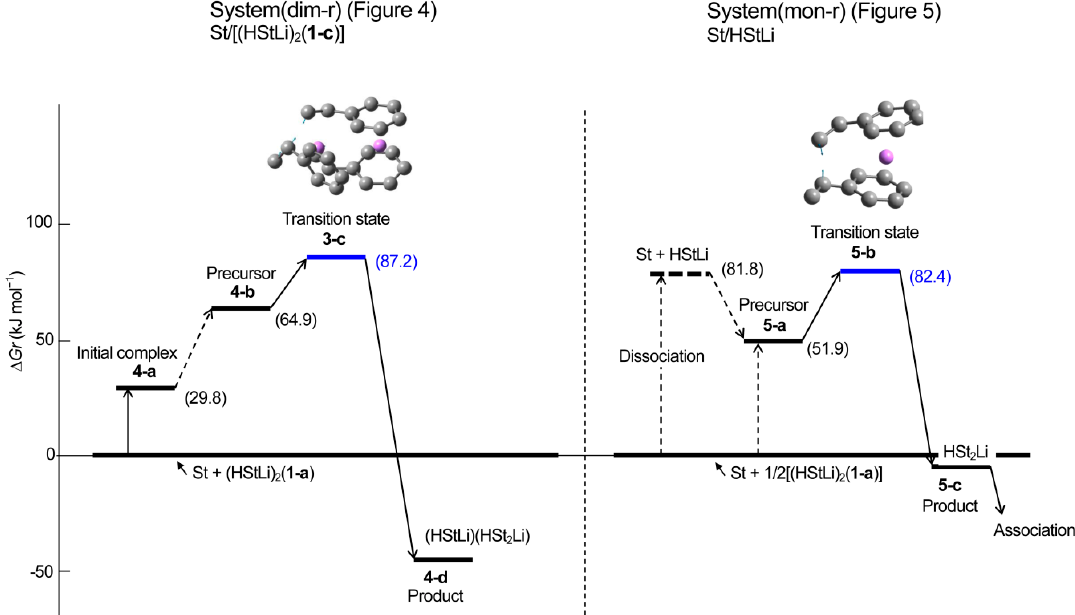
r)) and HStLi (system(mon-r)). and HStLi (system(mon-r)). Polymers 2019 , 11 , x FOR PEER REVIEW